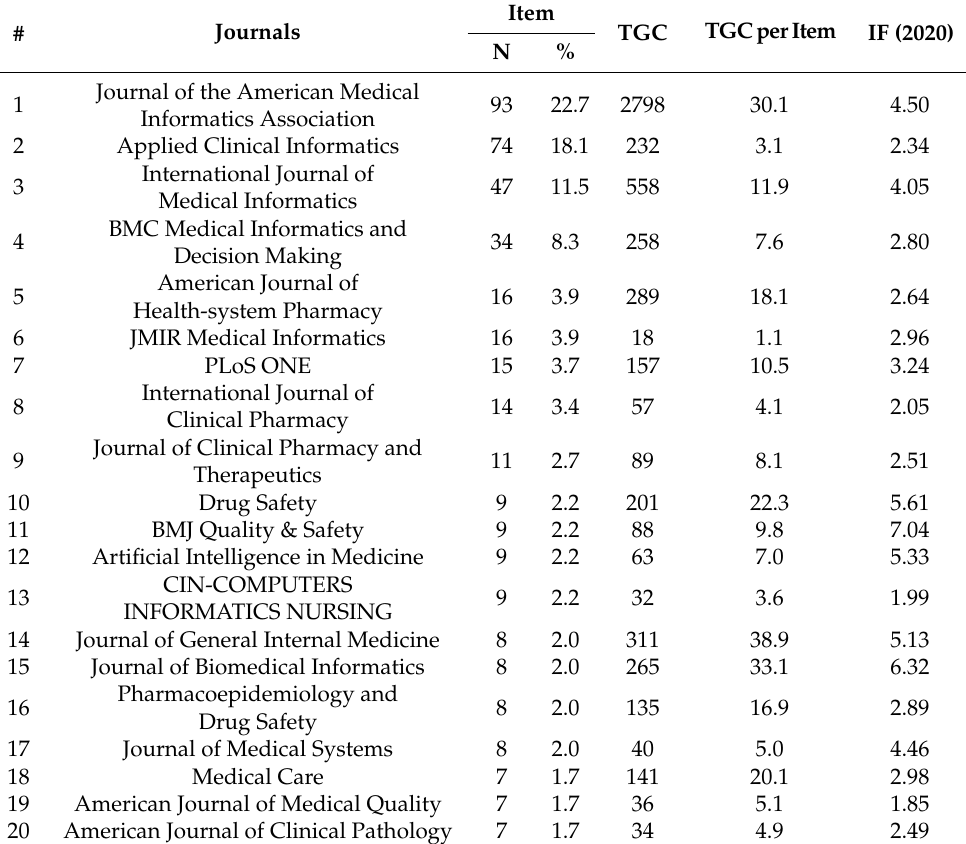
Table 1. Most influential journals (sorted by the number of publications).